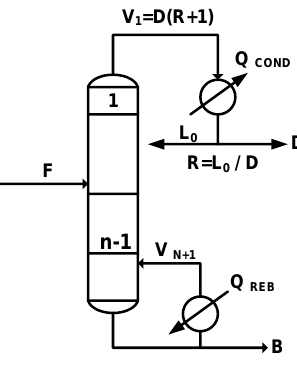
Figure 3. A conventional distillation column.